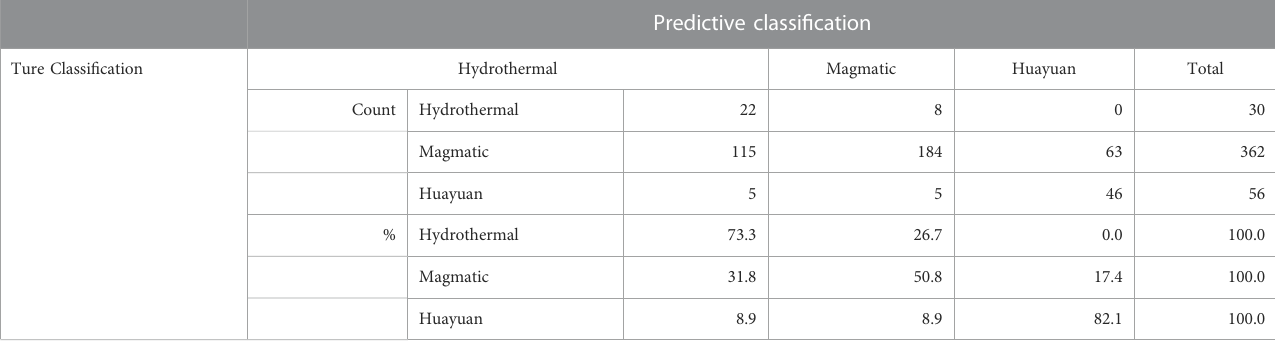
TABLE 1 Fisher discriminant predictive classi fi cation, based on major element